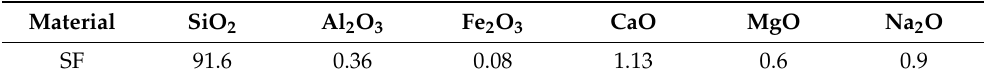
Table 3. Chemical composition of silicon powder.